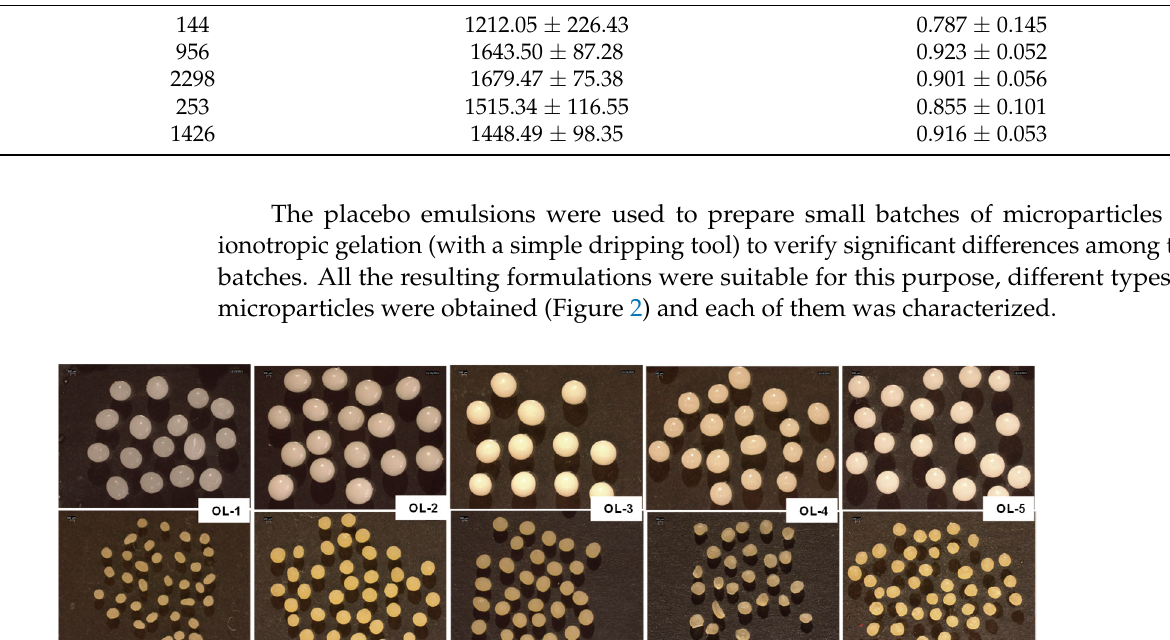
Table 3. Characteristics of the emulsions and of the dried microparticles produced in the preliminary study. Emulsion Viscosity (cP)